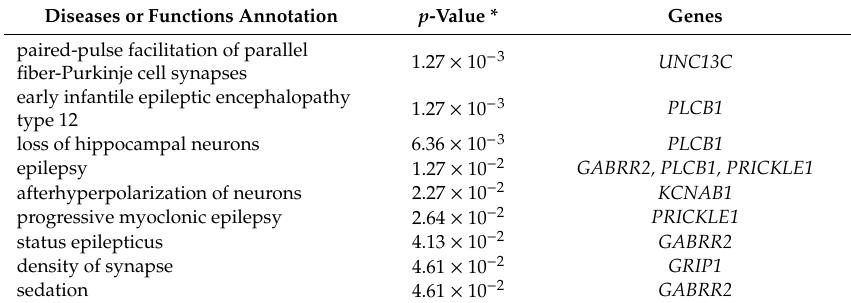
Table 8. Neurological functions associated with genes implicated by Perseverative behavior QTNs.